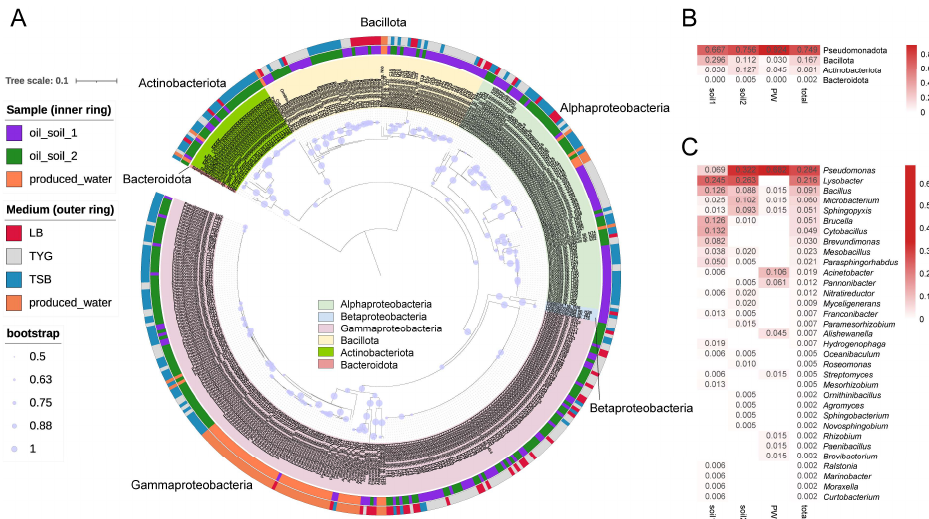
Figure 4. Taxonomic distribution of isolates from petroleum-contaminated soil and oilfield-produced water samples using the SCCBB approach. ( A ) Phylogenetic tree based on the 16S rRNA sequences of the isolates. ( B ) The taxonomic compositions of isolates from different samples at the phylum level. The numbers in the graduated color blocks represent the relative abundances of the taxa in the sample. ( C ) The taxonomic compositions of isolates from different samples at the genus level. The numbers in the graduated color blocks represent the relative abundances of the taxa in the sample. ( B , C ), soil1, oil-soil-1; soil2, oil-soil-2; PW, oilfield produced water.